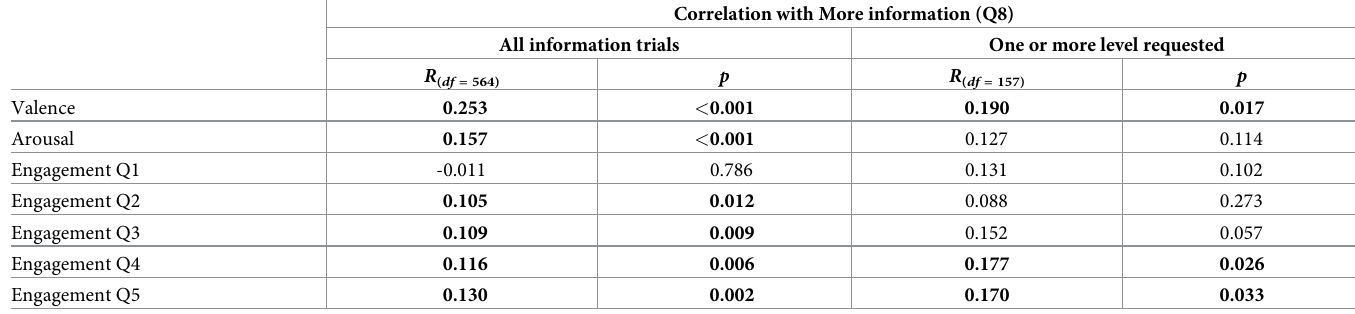
Table 6. Engagement’s effect on the desire to receive further information about an